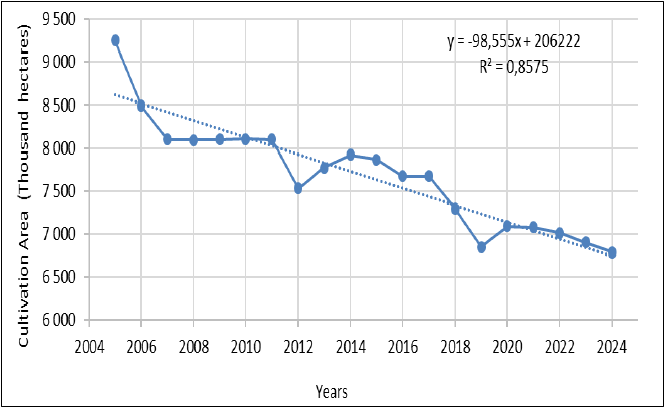
Figure 3: Wheat cultivation areas between the 2005-2024 year in Turkey.